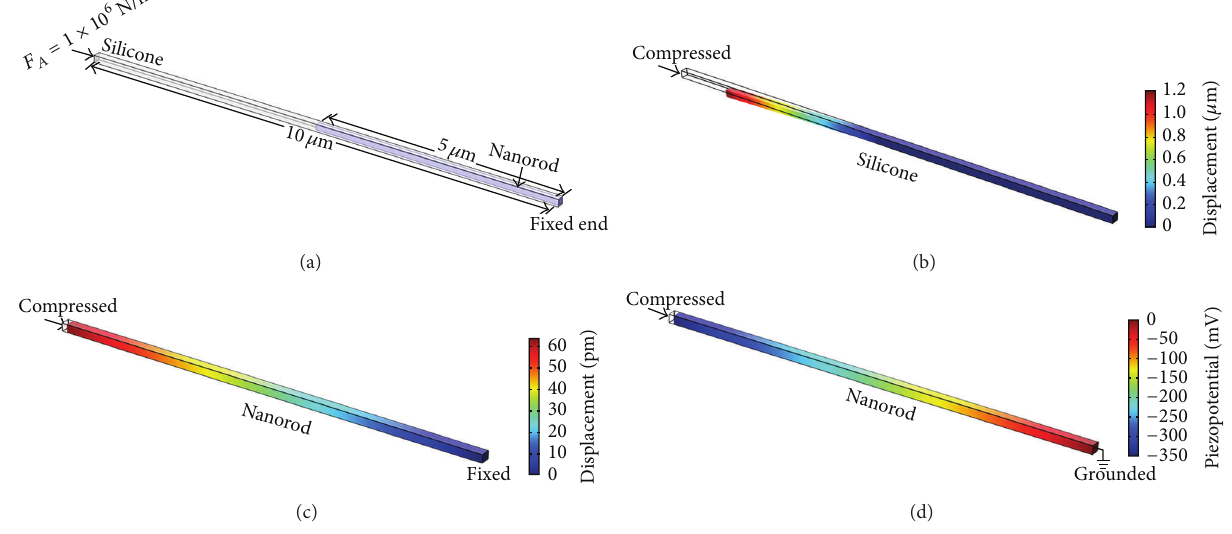
Figure 7: FEM static simulation of the electromechanical conversion behavior of a vertically compressed device. (a) Schematic diagram of model. (b) The deformation of silicone. (c) The deformation of nanorod. (d) The piezoelectric potential of nanorod.